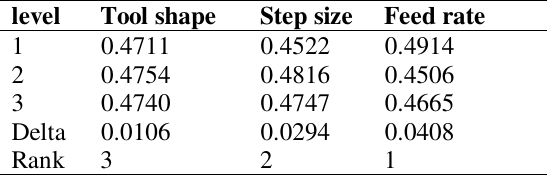
Means larger results (45 ◦ forming